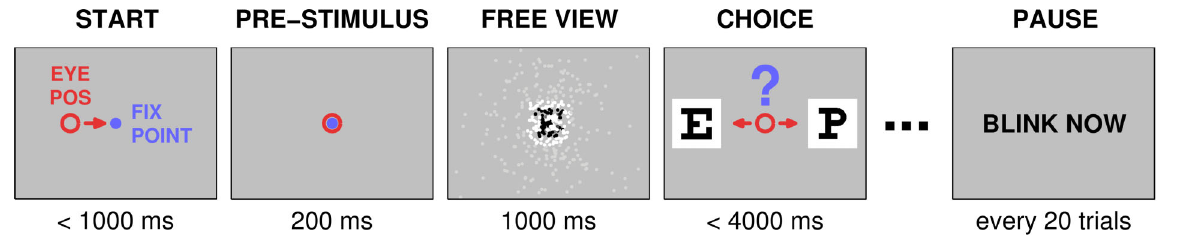
Figure 2. Letter recognition task. Each gray rectangle represents the image shown on the computer monitor during one phase of a trial. Subject eye position is shown as a red circle. The Free View period is represented here under simulated thalamic prosthetic vision as in the Primary experiment: each dot (white, gray, black) is one simulated phosphene; black and white dots represent phosphenes that were presented to the subject while gray ones were not presented and are shown only to indicate how pattern density decreases with eccentricity and that phosphenes spanned the entire visual field (see Section 2.5). During the Validation experiment, cues presented in the Free View period were shown in the clear, rather than through a phosphene field, but the task was otherwise